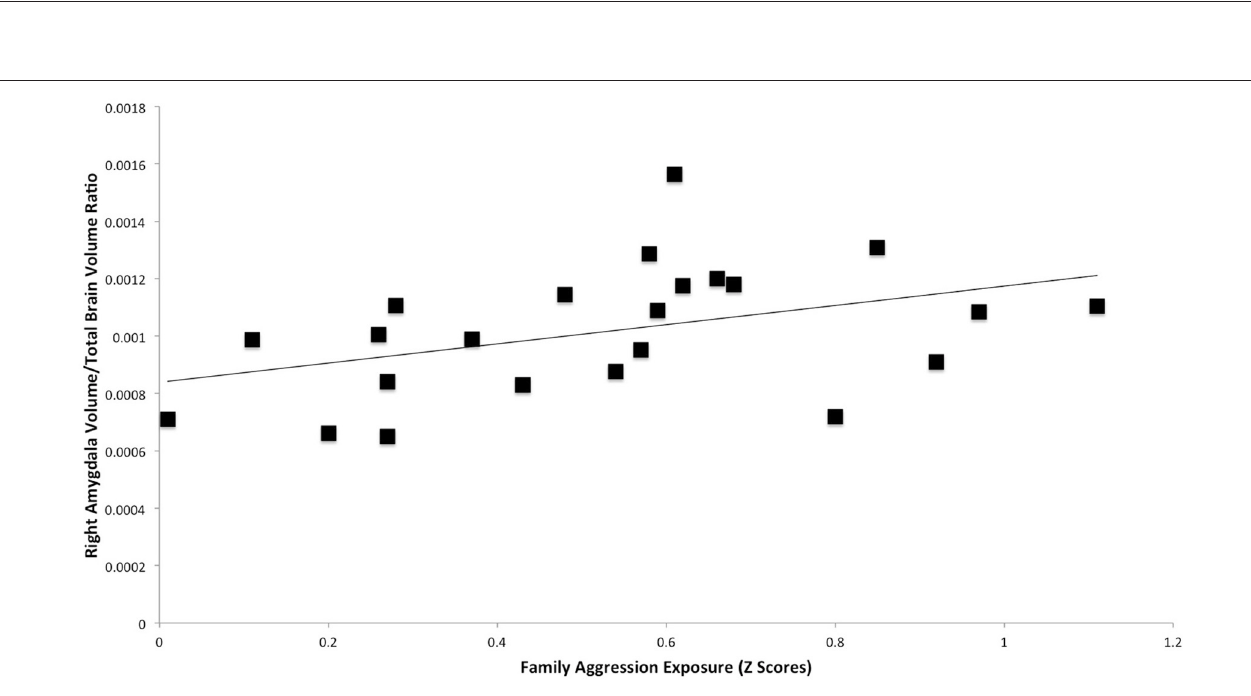
FIGURE 3 | Results of a partial correlation representing the relationship between family aggression exposure and right amygdala volume measured by manual segmentation. A significant positive correlation was found between right amygdala volume ( β = 0.47, p < 0.05) and family aggression exposure accounting for total brain